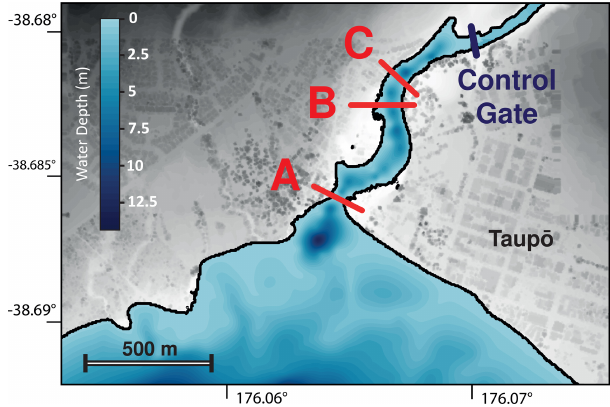
Figure 3. The Waikato River inlet from Lake Taup¯o, with terrain detail. Cross-sections where hydrographs of the river are calculated are given in red, and the lake-river control gate is given in navy blue.